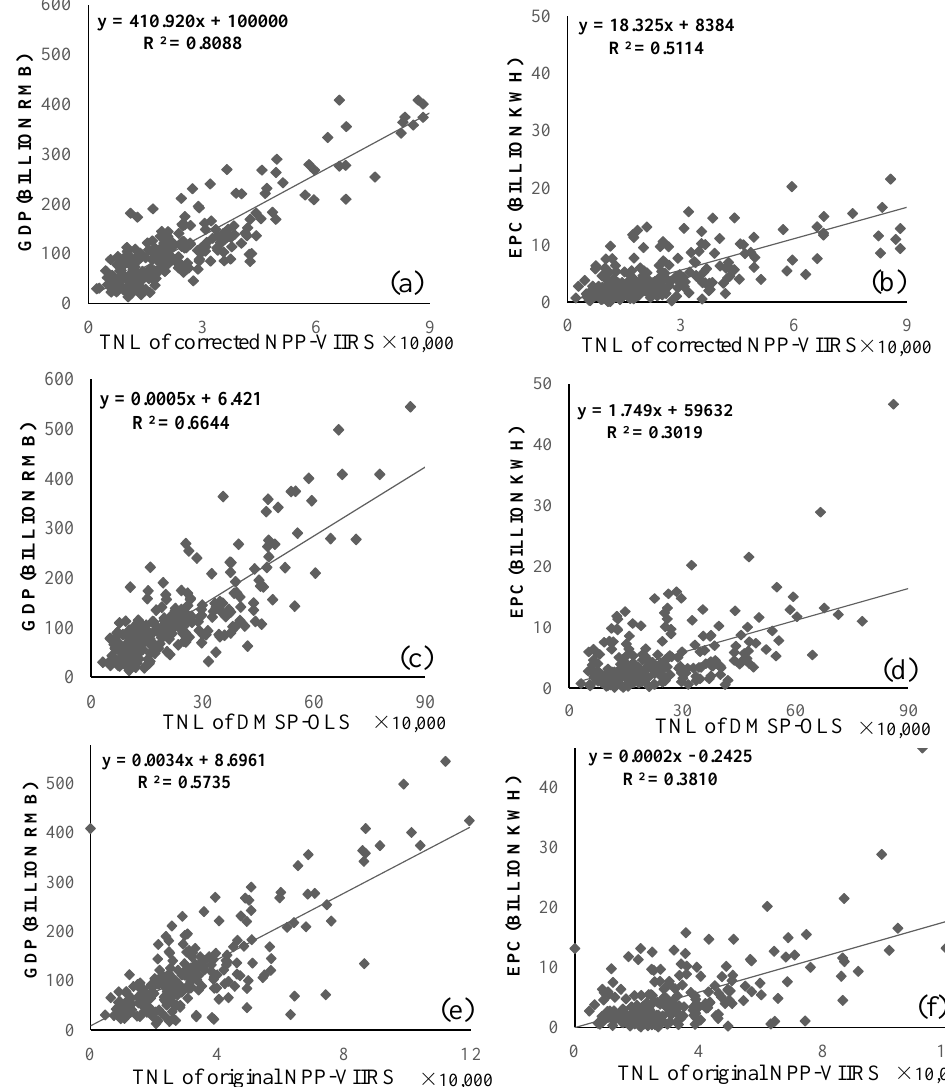
Figure 6. The scatter diagram of linear regression analysis in prefectural units: ( a ) the total nighttime light (TNL) of corrected NPP-VIIRS data and the gross domestic product (GDP); ( b ) the TNL of corrected NPP-VIIRS data and the EPC; ( c ) the TNL of DMSP-OLS data and the GDP; ( d ) the TNL of DMSP-OLS data and the EPC; ( e ) the TNL of original